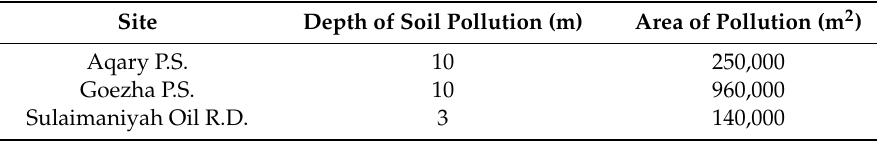
Table 13. Result of area and depth of pollution in ground at all studied site. Site Depth of Soil Pollution